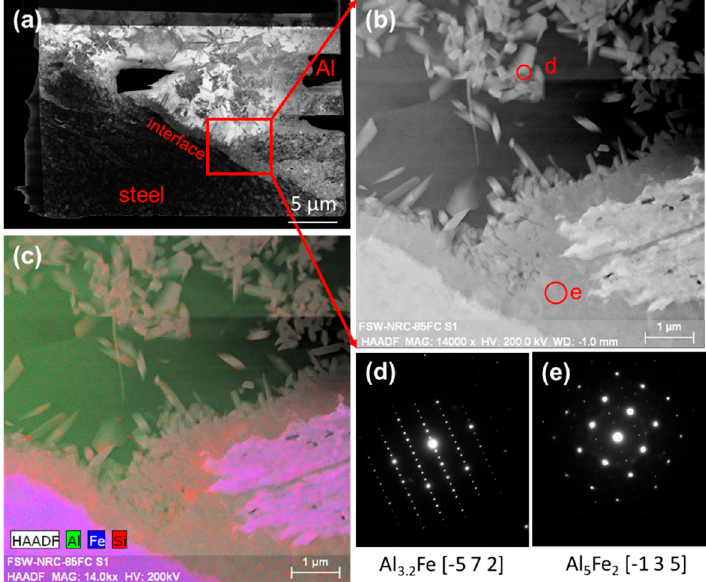
Figure 13. TEM micrographs of the interfacial microstructure at the stir zone of sample B: ( a ) low magnification STEM images, ( b ) high angle annular dark field (HAADF) interfacial image, ( c ) EDS combination elemental map and SAD patterns of ( d ) Al 3.2 Fe and ( e ) Al 5 Fe 2 .